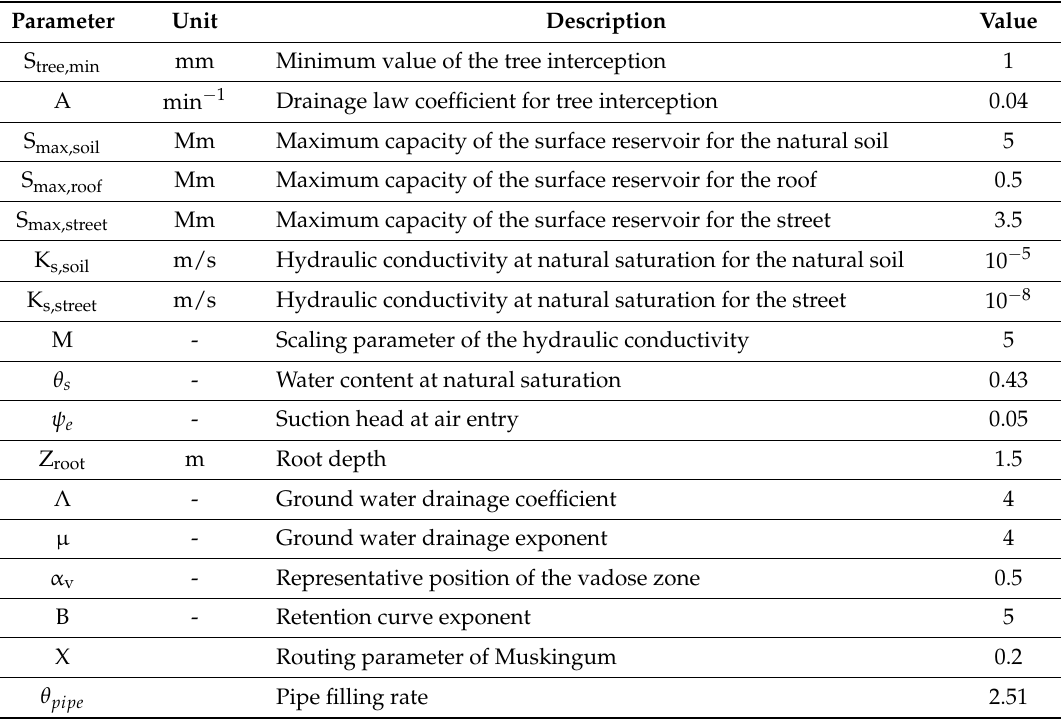
Table A3. Values of physical and transfer parameters for hydrological modeling of the Le Perreux